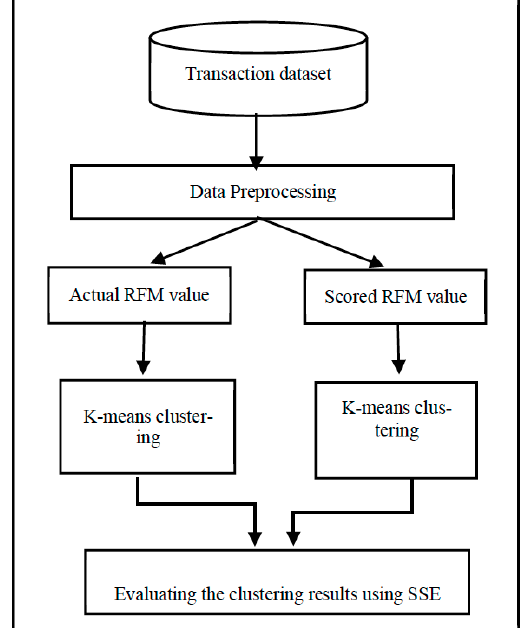
Figure 1. Actual RFM and Scored RFM